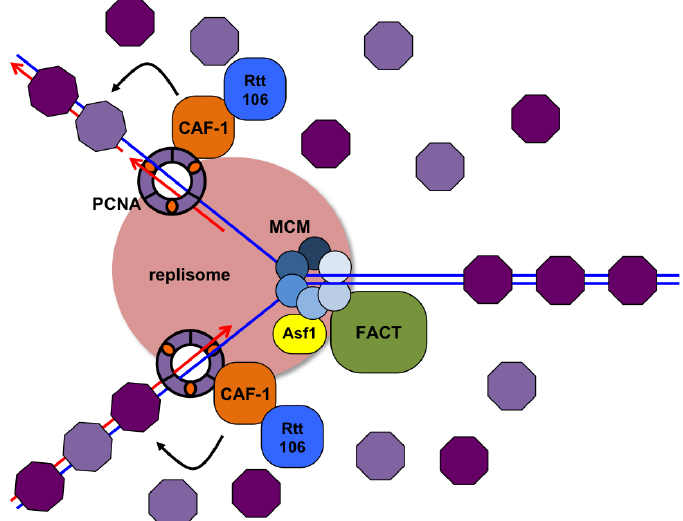
Figure 5. Nucleosome displacement and deposition during DNA replication. Histones are removed from chromatin ahead of the replication fork. FACT may facilitate this process. Asf1 recruits histone H3-H4 dimers to the replication fork. CAF-1 and Rtt106 load newly synthesized (light purple) histones to establish chromatin behind the fork. Previously loaded histones (dark purple) are also deposited on both daughter DNA strands. The histone chaperones involved in these processes are associated with replisome proteins: CAF-1/Rtt106 with PCNA and FACT/Asf1 with